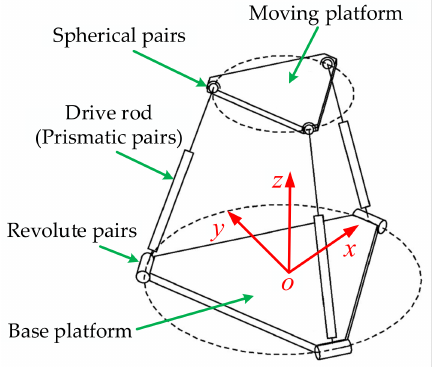
Figure 1. 3-RPS parallel